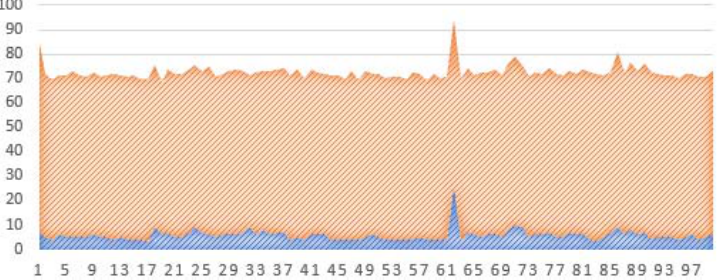
Figure 11 – Processing vs. communication